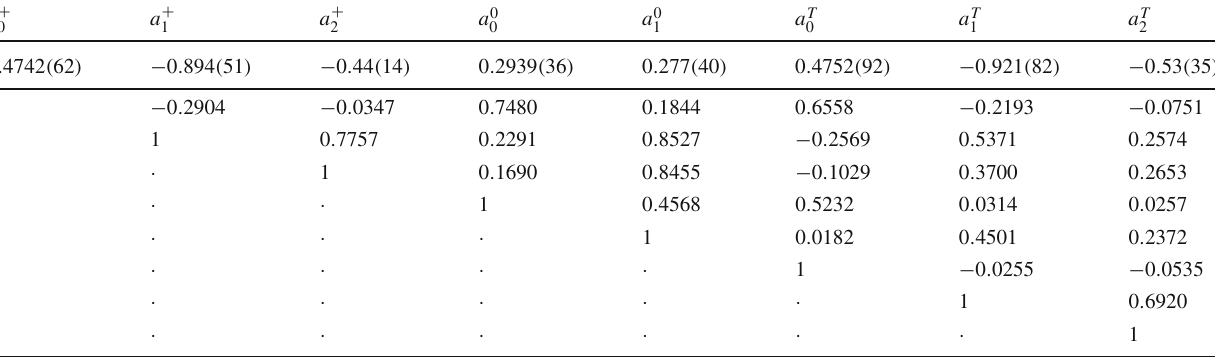
Table 6 Values of the z -expansion coefficients and correlation matrix obtained by our combined fit to the B → K form factors computed by HPQCD [33] and FNAL/MILC [34] (with χ 2 consider the parameterization from Eqs. (A2)–(A4) with N = 3, and